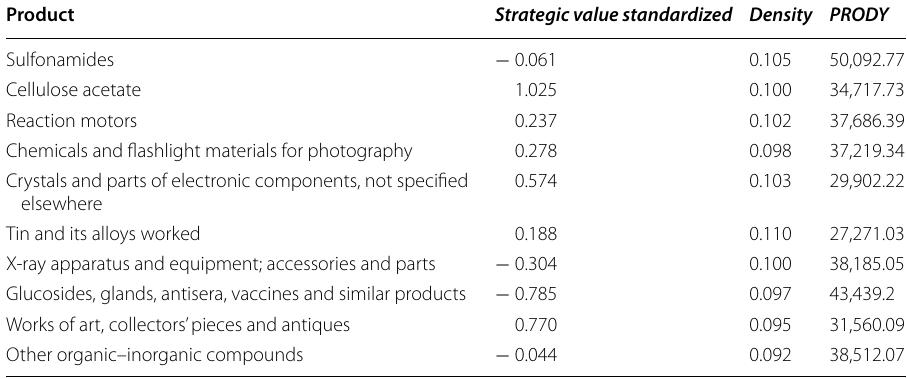
Table 8 “Best” 10 products for structural transformation in Colombia. Source : Author’s calculations